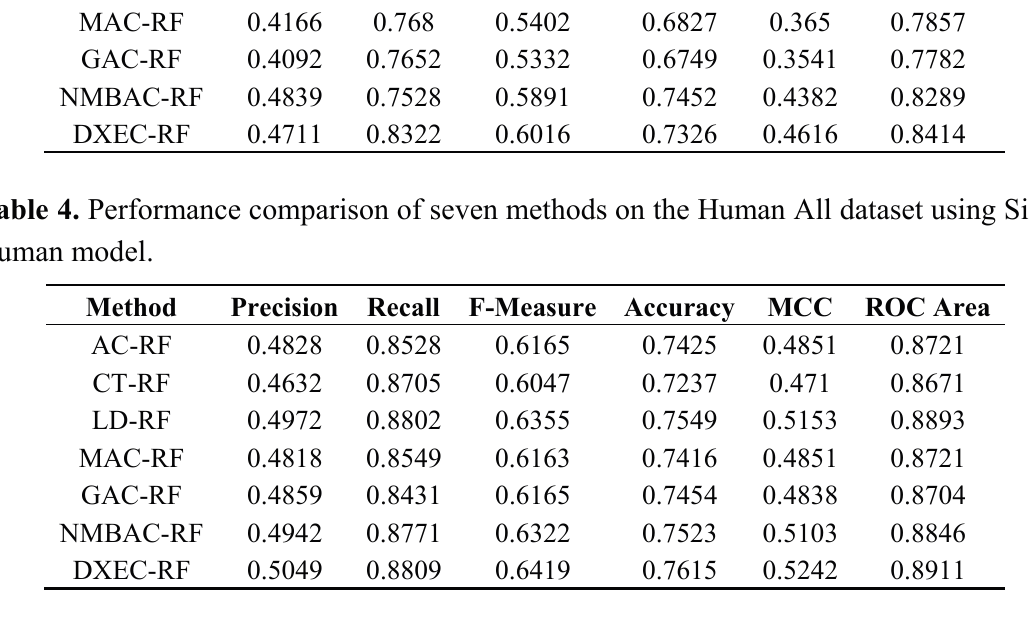
Figure 19. ROC curves of seven methods on the Yeast All dataset. ( A ) Gold Yeast model and ( B ) Silver Yeast